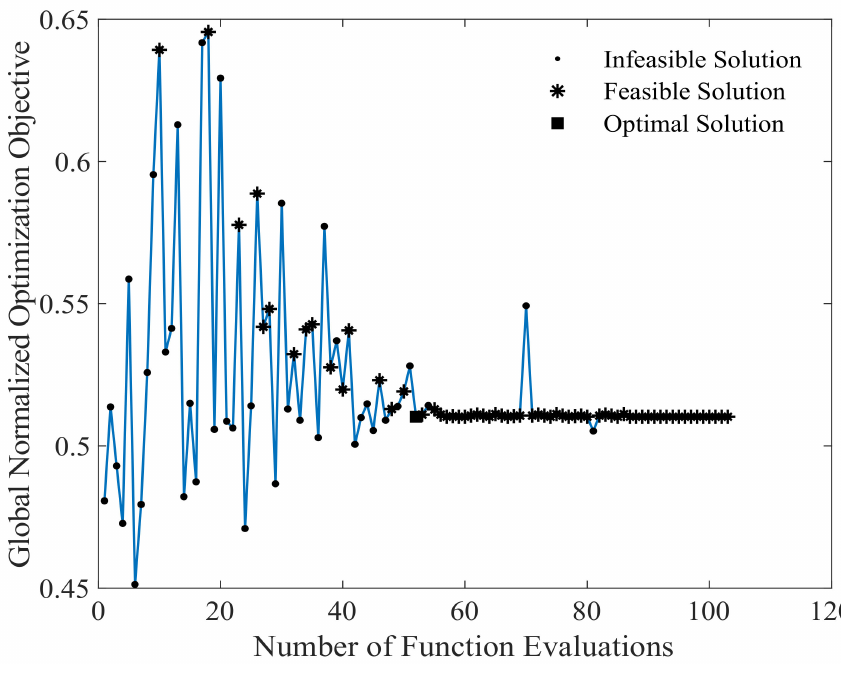
Figure 25. Iterative results of AMGO. Table 4. Solution results of GA and AMGO.